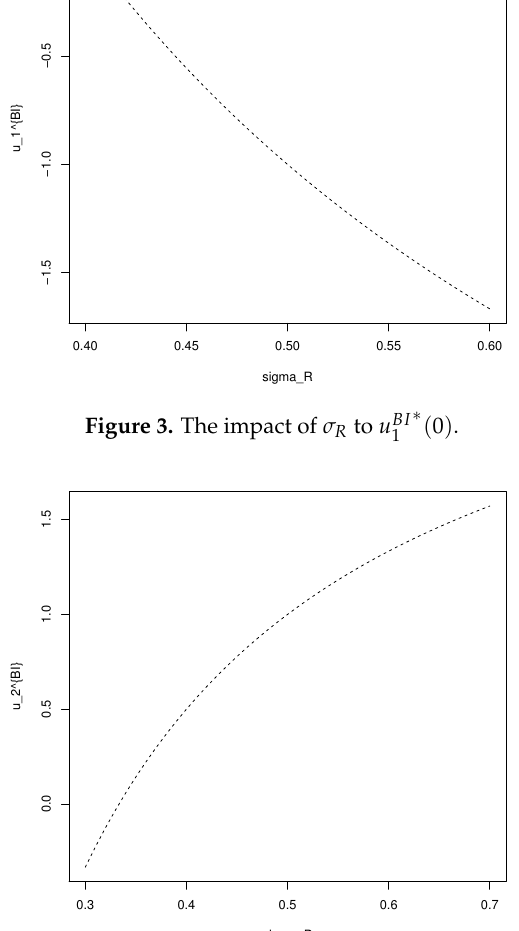
∗ ( 0 ) with positive λ P . 2